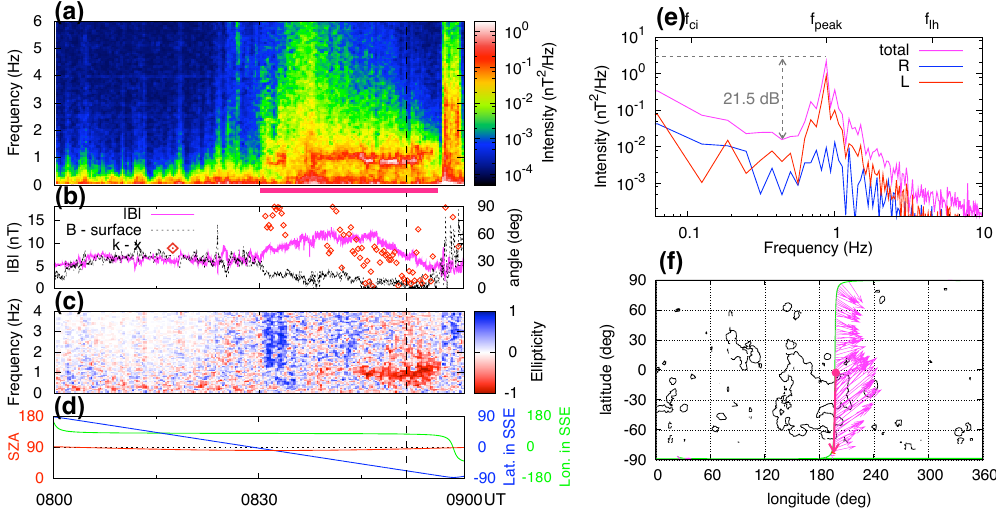
Fig. 1. Monochromatic whistler waves detected by Kaguya on 13 January 2008. Left panels are (a) the fast Fourier transform (FFT) spectrum, (b) magnetic field strength ( | B | ) , angle of magnetic field to lunar surface, and angle of the wave vector ( k ) to the sunward direction ( x) , (c) ellipticity spectrum, and (d) position of the spacecraft in solar zenith angle (SZA) and Selenocentric Solar Ecliptic (SSE) coordinates (Lat.: latitude, Lon.: longitude). Ellipticity is defined as (R − L)/(R + L), where R and L represent the intensities of the right- and left-hand polarized component of the waves, respectively. The right top panel (e) shows the intensities of the total, right-, and left-hand polarized component of the waves at 08:52UT (this time is indicated by a dashed line in the left panels). The right bottom panel (f) illustrates the spacecraft orbit during 08:00–09:00UT and magnetic field vectors in the selenographical coordinates. The contour indicates 20nT surface magnetic field strength obtained from LP observations (courtesy of J. S. Halekas). The thick red arrow superposed on the orbit represents the period indicated by a bar just below the FFT spectrum panel (a)